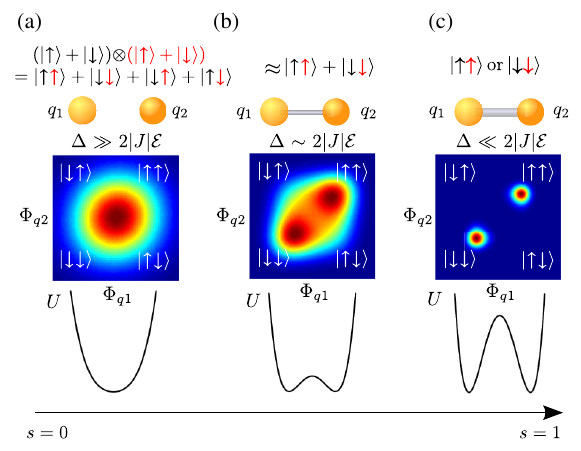
FIG. 2. An illustration of entanglement between two qubits 0 and J < 0 . We plot calculations of the during QA with h i ¼ two-qubit ground-state wave-function modulus squared in the basis of Φ and Φ , the flux through the bodies of q 1 and q 2 , q 1 q 2 respectively. The color scale encodes the probability density with red corresponding to high probability density and blue corre- sponding to low probability density. We use Hamiltonian (1) and the energies in Fig. 1(d) for the calculation. The four quadrants represent the four possible states of the two-qubit system in the computation basis. We also plot the single-qubit potential energy ( U versus Φ ) calculated from measured device parameters. q 1 (a) At s ¼ 0 ( Δ ≫ 2 j J j E ∼ 0 ), the qubits weakly interact and are ffiffiffi p 2 each in their ground state ð 1 = Þðj ↑ i þ j ↓ iÞ , which is delocal- ized in the computation basis. The wave function shows no correlation between q 1 and q 2 and, therefore, their wave functions are separable. (b) At intermediate s ( Δ ∼ 2 j J j E ), the qubits are entangled. The state of one qubit is not separable from the state of the other, as the ground state of the system is approximately ffiffiffi p 2 . A clear correlation is seen between q 1 jþi ≡ ðj ↑↑ i þ j ↓↓ iÞ = and q 2 . (c) As s → 1 , Δ ≪ 2 j J j E , and the ground state of the system approaches jþi . However, the energy gap g between the ground state ( jþi ) and the first excited state ( j − i ) is closing. When the qubits are coupled to a bath with temperature T and g < k T , the system is in a mixed state of jþi and j − i and B entanglement is